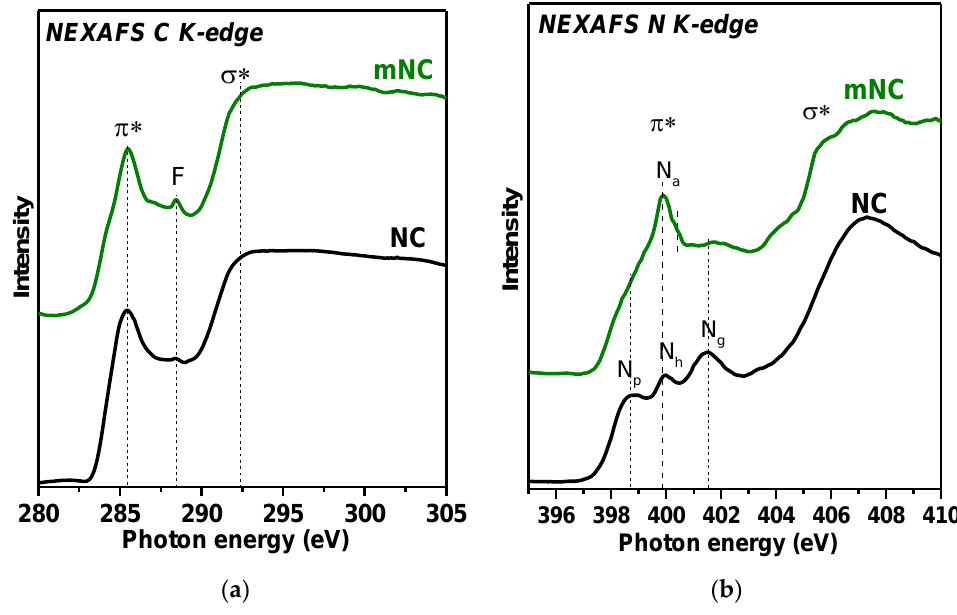
Figure 3. NEXAFS ( a ) C K-edge and ( b ) N K-edge spectra of NC and mNC samples. The NEXAFS N K-edge spectrum of NC shows a series of peaks in the energy range from 398.0 to 403.0 eV attributed to 1s → π* electron transitions , and a broad spectral feature at energies above 405.0 eV due to 1s → σ* electron transitions. The energy position of the three π* peaks reveals the presence of N p (398.7 eV), N h (399.9 eV) and N g (400.4 eV) [50,69,70]. Oxygenated nitrogen was detected by XPS appears in the N K-edge spectrum as a weak shoulder at 404.0 eV. The main difference between the spectra of NC and mNC is an extra peak at 400.0 eV, with shoulders on the higher-energy side around 400.4 eV (all features are denoted as N a ). This peak coincides with the N h peak in the spectrum of NC, but it is doubtful that the treatment of pre-activated NC with ammonia will only lead to the incorporation of hydrogenated nitrogen into aromatic rings. According to the XPS N 1s spectrum of mNC, the most probable scenario is the formation of predominantly imine, amine and amide groups at the edges of carbon defects. According to reported NEXAFS data, N 1s → π* excitations in unsaturated imine (C=N‒) and amine (‒NH 2 ) groups give a resonance at ~399.0 – 400.8 eV, while transitions in amide ( − C(O)NH 2 ) groups appear at higher energies of 401.0‒401.4 eV [56,67,71]. It should be noted that the peaks N p and N g become weaker and wider in the mNC spectrum due to the lower concentration of the pyridinic and graphitic nitrogen states in the modified sample.